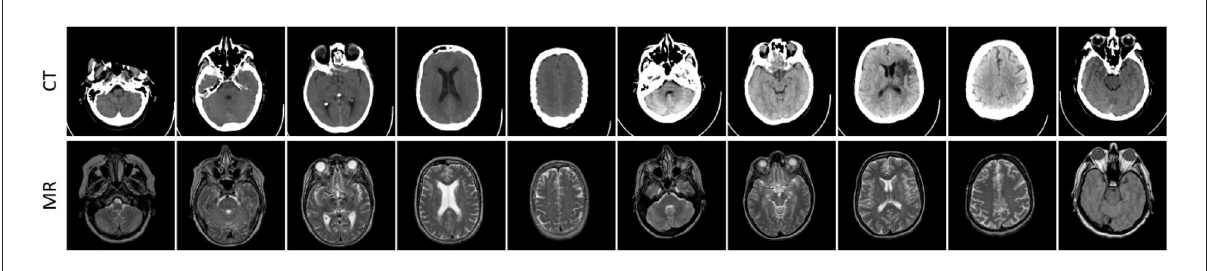
FIGURE3 Ten pairs of images in the CT-MR image dataset.